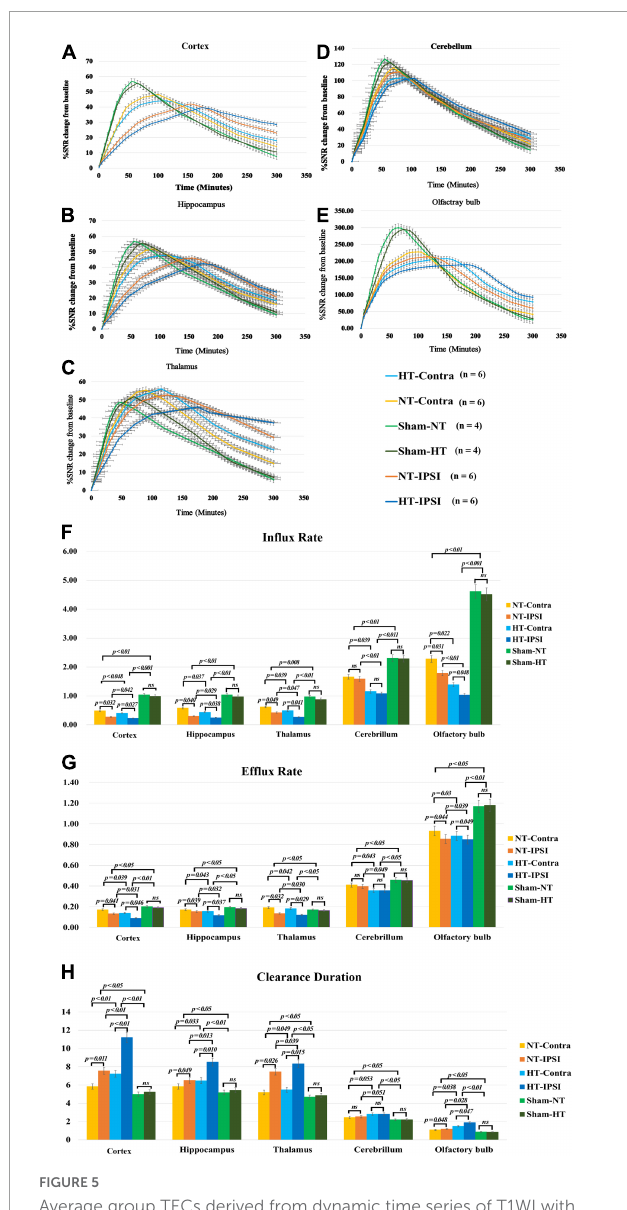
FIGURE5 Average group TECs derived from dynamic time series of T1WI with Gd-DTPA. SNR% changes from baseline over time obtained from coronal T1WI sections encompassing bilateral brain subregions, including the ipsilateral and contralateral cortex (A) , ipsilateral and contralateral hippocampus (B) , and ipsilateral and contralateral thalamus (C) . Ipsilateral and contralateral cerebellum (D) and ipsilateral and contralateral olfactory bulb (E) . The quantitative results and group comparison of infusion rate (F) , clearance rate (G) , and clearance time constant (H) were obtained from the corresponding TECs. Within the major experimental period, significantly lower infusion and clearance rates and larger clearance time constants were detected in all brain subregions in the TBI-HT group compared with the TBI-NT group and in the TBI-NT group compared with both the Sham-NT and Sham-HT groups. Similar results were also found in all ipsilateral subregions except the cerebellum in the TBI-HT and TBI-NT groups compared with the contralateral subregions but not in the sham injury groups. Data in panels (F–H) : Sham-NT n = 4, Sham-HT n = 4, TBI-NT n = 6, TBI-HT n = 6, pooled data from four independent experiments. All n values refer to the number of rats used, and the error bars depict the mean ± SD. One-way ANOVA was used to calculate p -values with Bonferroni’s multiple comparison test, and p < 0.05 indicated significance. HT-contra, contralateral subregion of TBI-HT rat brain; HT-IPSI, ipsilateral subregion of TBI-HT rat brain; NT-contra, contralateral subregion of TBI-NT rat brain;